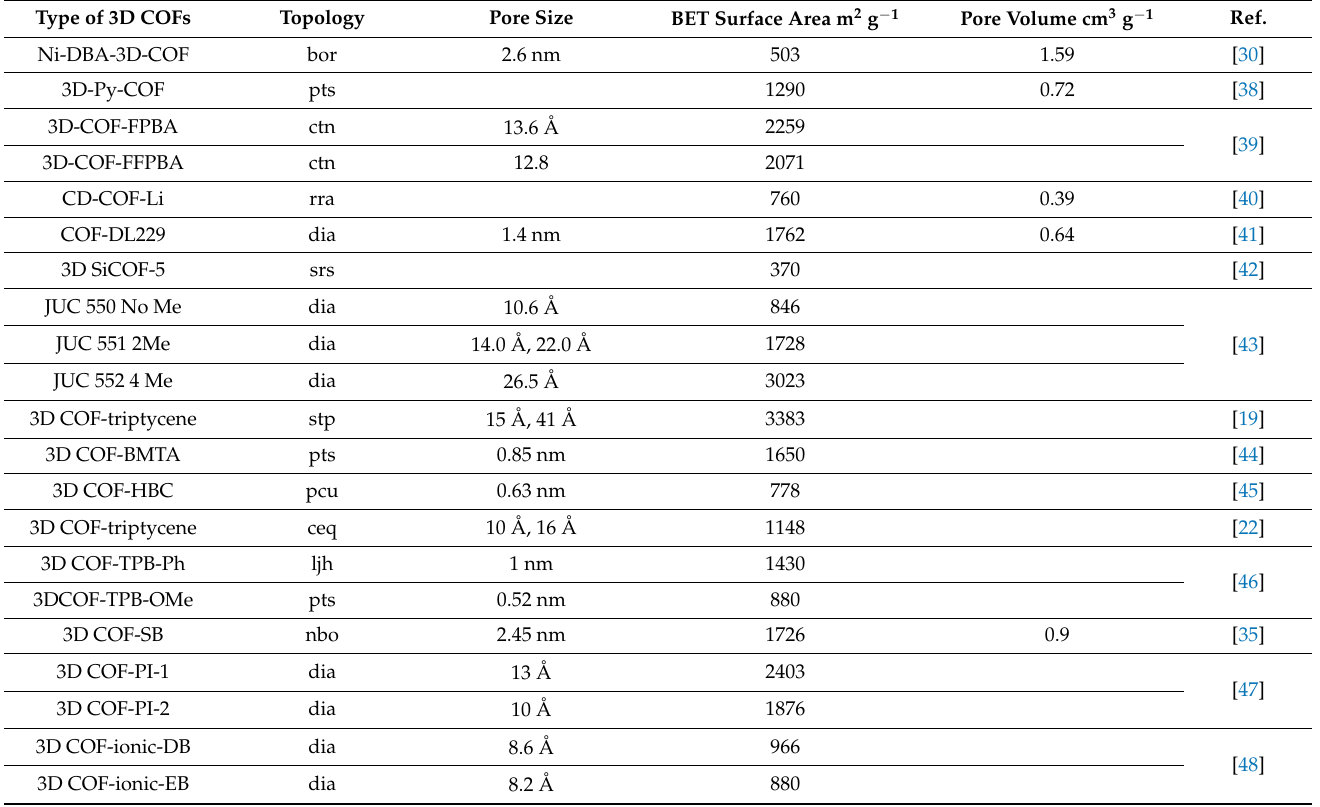
Table 2. The parameters and topology of different 3D